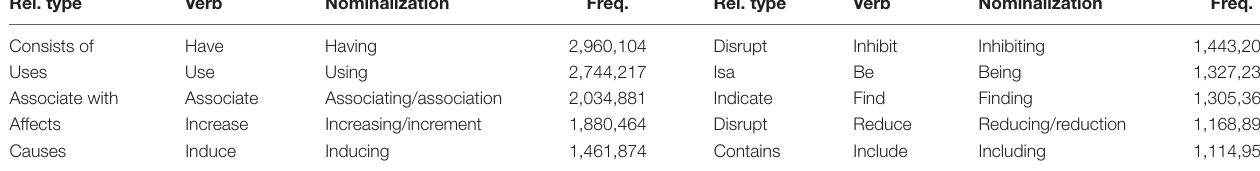
TaBle 3 | Top 10 biomedical verbs by